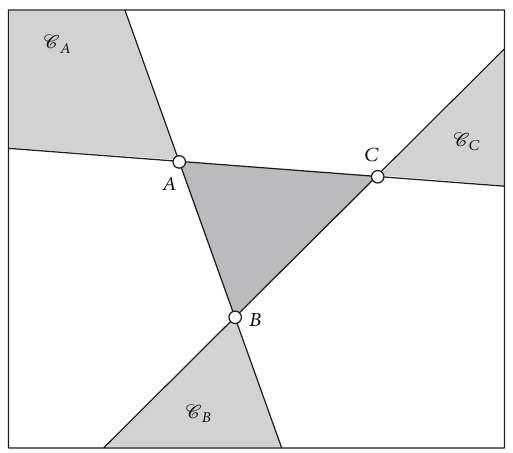
Figure 1: Geometric representation of the inequality in (16). Figure 2: Triangle with